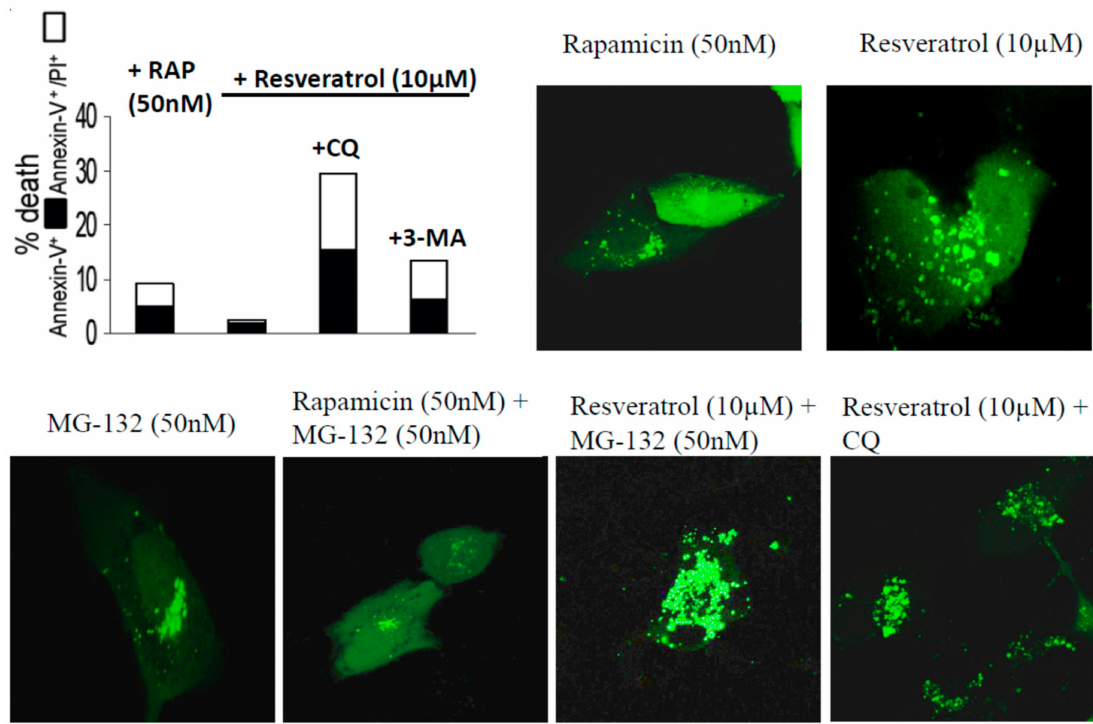
Figure 3. ARPE-19 cells treated by rapamycin (RAP), resveratrol, MG-132, and chloroquine (CQ).